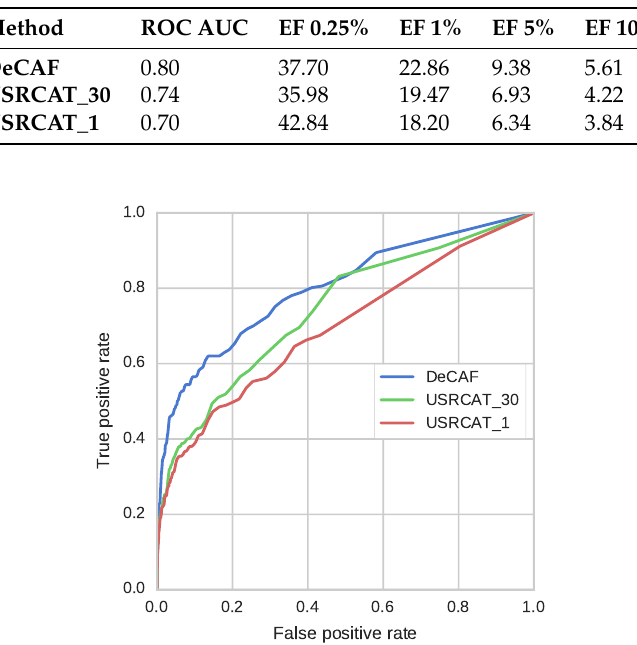
Table 2. Enrichment factors and ROC AUC for DeCAF and USRCAT. EF values were calculated for 0.25%, 1%, 5% and 10% of top ranked predictions.